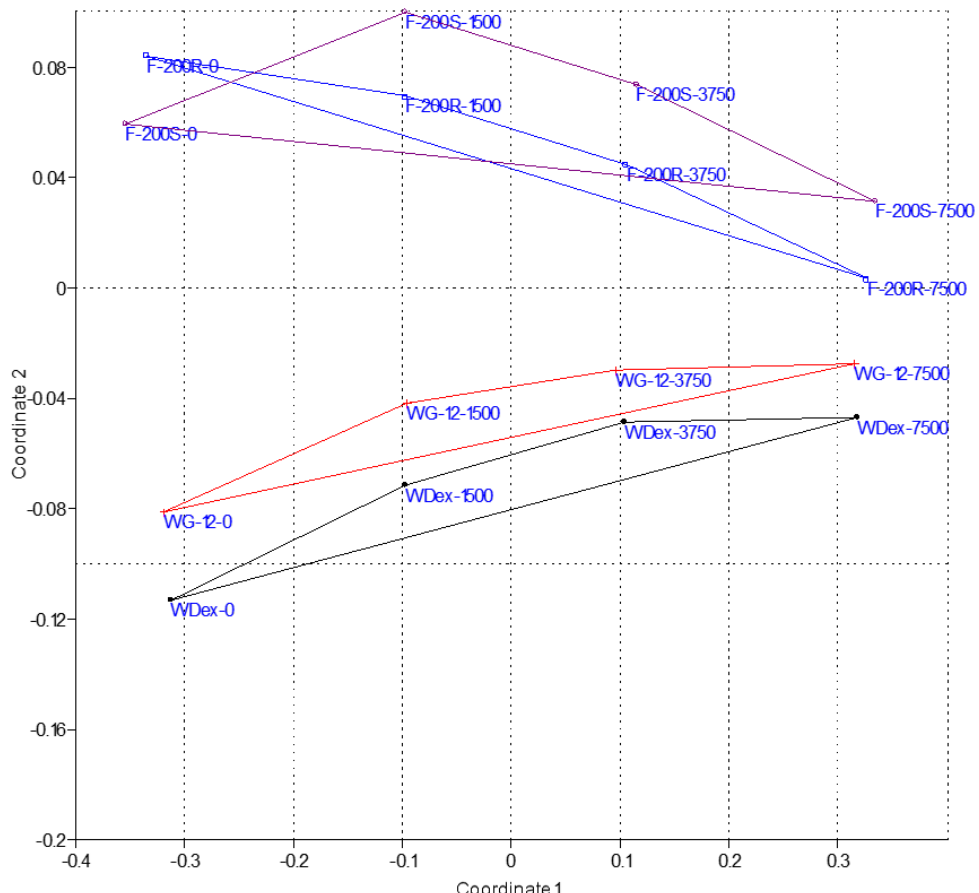
Figure 5. Multidimensional scaling results of activated carbon parameters, together with influence of added H 2 O ll on kinetic parameters of dyers removal from water solution.